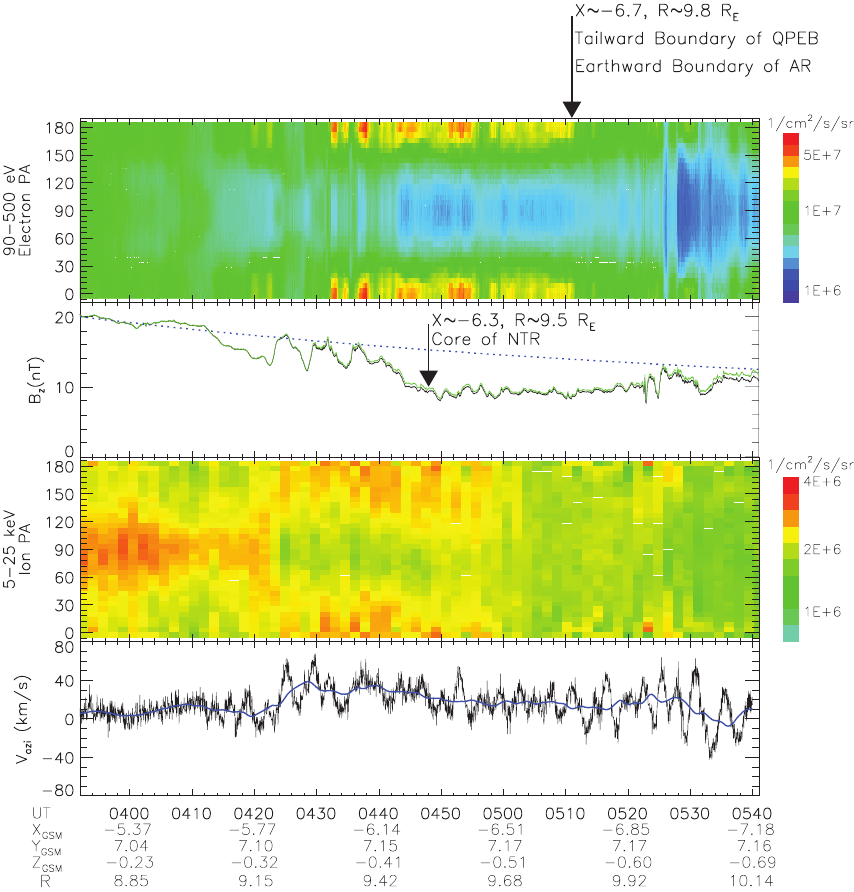
Fig. 8. Top panel shows the pitch-angle spectrogram of 90–500eV electrons; a tailward boundary of the QPEB region is marked (see text for details). The second panel shows the B z components (black curve) and the equatorial B z (green curve; see text for details) estimated from local observations; a dotted line indicates the R − 3 drop tendency of B z expected for a pure dipole field. The third panel shows the pitch-angle spectrogram of 5–25keV ions from ESA measurements; the fourth panel shows the azimuthal (positive duskward) ion flows. A blue curve denotes the low-passed DC component of the